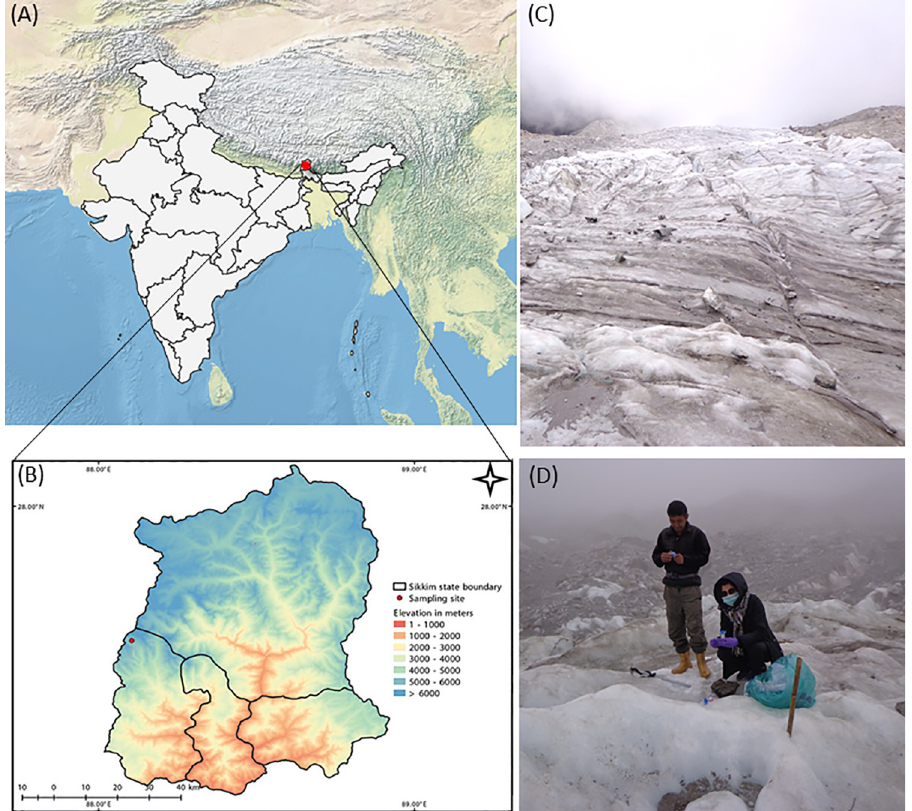
Fig 1. Map illustrating (A-B) geographical location of the sample collection site in Sikkim Himalaya, India. The red circle depicts the specific spot of the collected ice meltwater sample; (C-D) sampling site comprising the supraglacial site in the ablation zone of the East Rathong glacier. Made with Natural Earth, free vector, and raster map data @ naturalearthdata.com. The map was made in QGIS version 3.0.0 (URL: http://qgis.org). [The individuals in the manuscript Fig 1(D) have given written informed consent (as outlined in PLOS consent form) to publish the